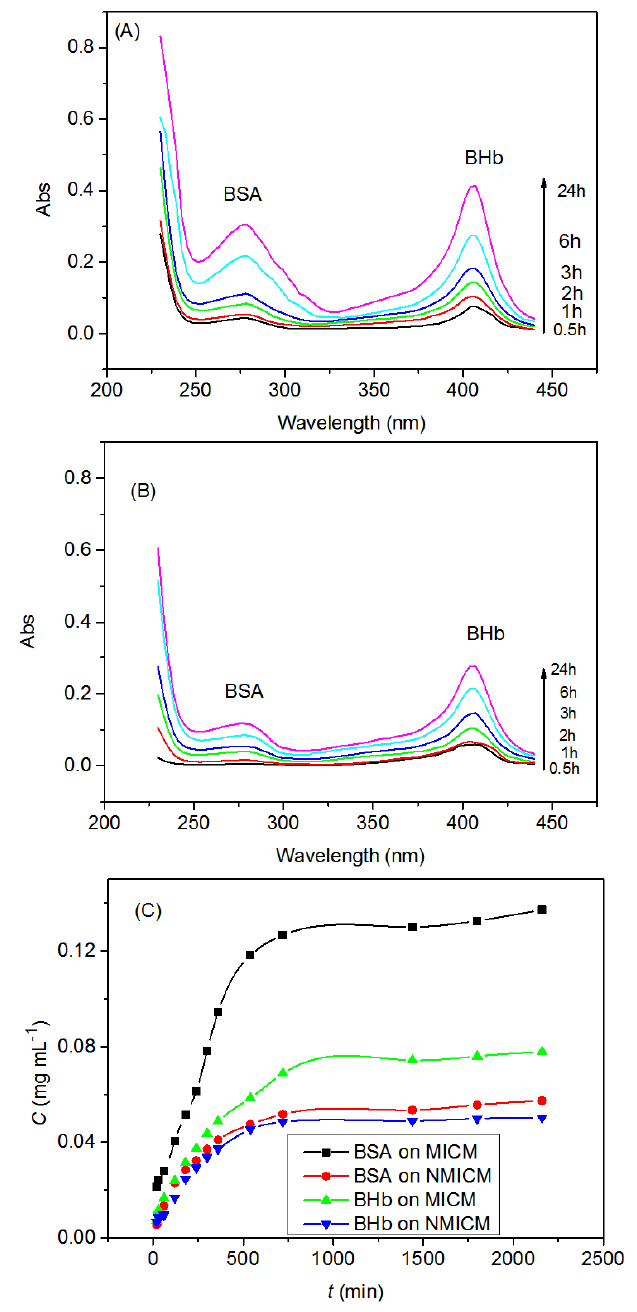
Figure 9. Typical UV-spectra of the BSA/BHb mixed solution in the receptor chamber for MICM ( A ), NMICM ( B ) and the permeation kinetic curves ( C ).